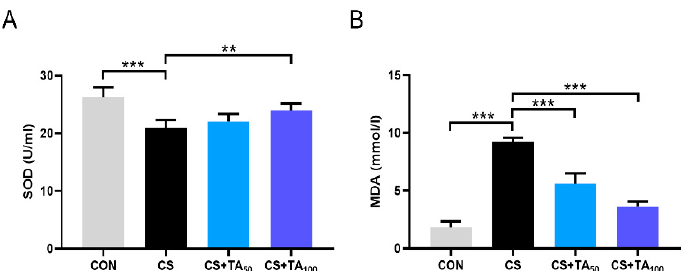
Figure 5. TA protects against oxidative stress in CS-exposed COPD mice. ( A ) Superoxide dismutase (SOD) activity and ( B ) malondialdehyde (MDA) levels in the serum were measured. ** P < 0.01, *** P < 0.001.